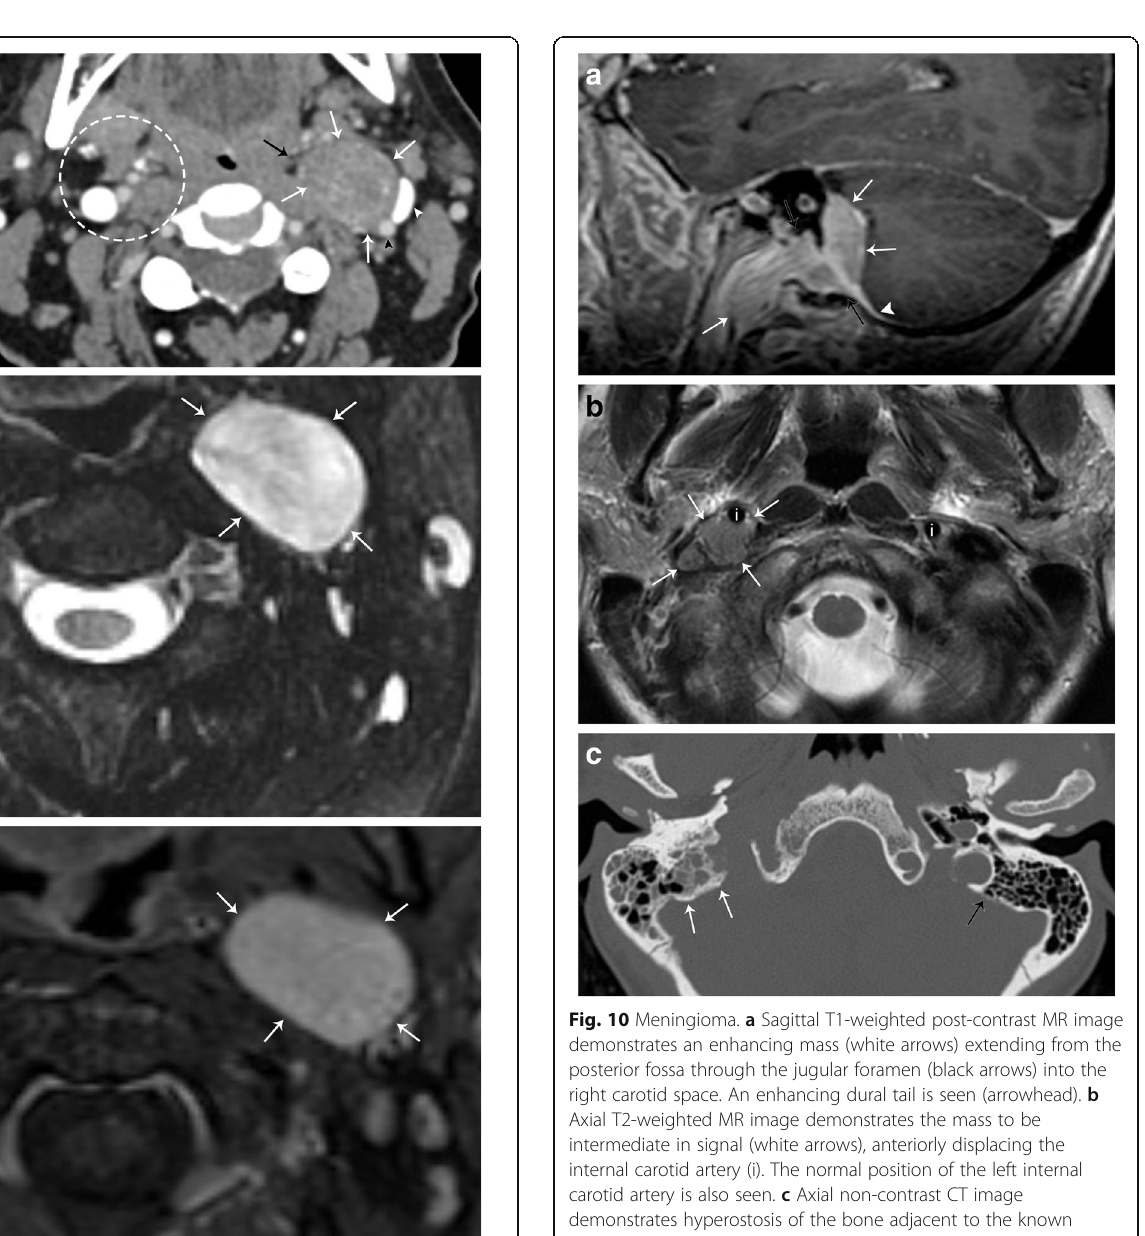
the pseudoaneurysm can partially thrombose. MRI with T1-weighted fat-suppressed sequences allows for evaluation of intraluminal thrombus and of pseudoaneurysm sac size.